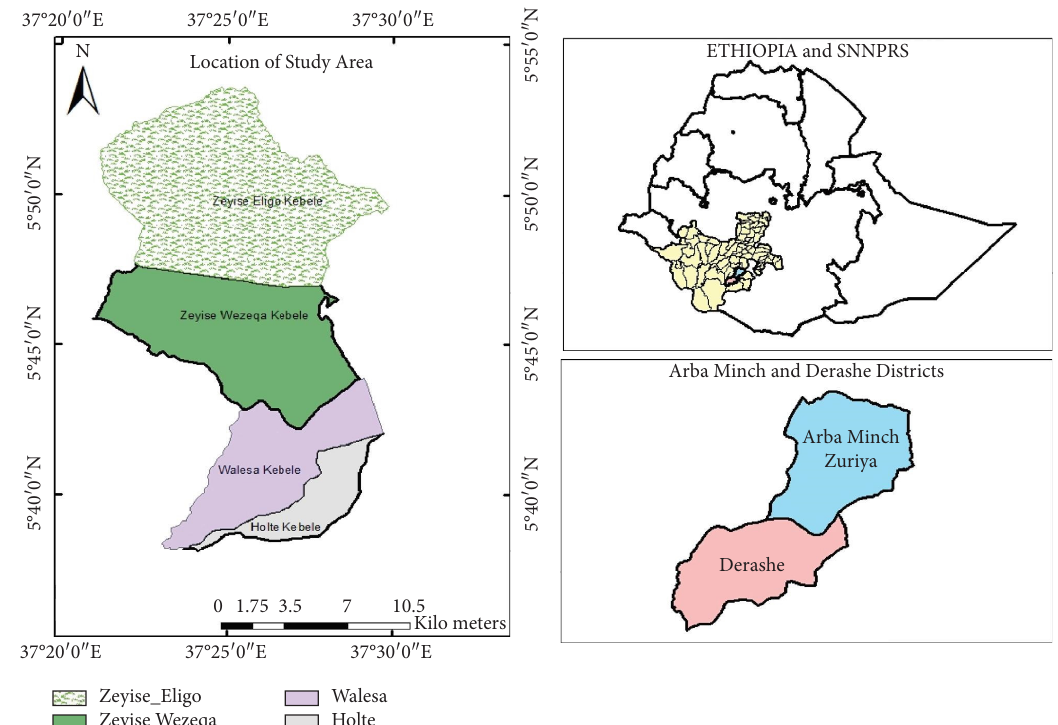
Figure 3: Map of Arba Minch Zuriya district, Zeyse Eligo, and Zeyse Wezeqa Kebeles; Derashe district, Holte and Walessa Kebeles.